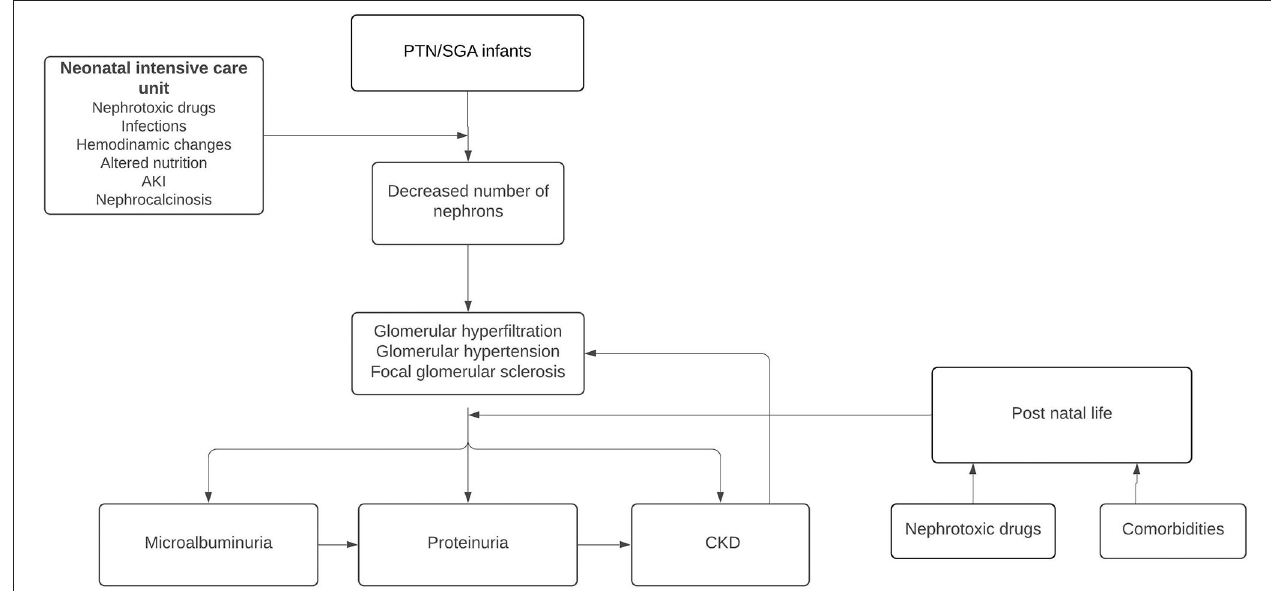
FIGURE 2 | Pathophysiological consequences of altered nephrogenesis in preterm newborns (PTN) and SGA infants.